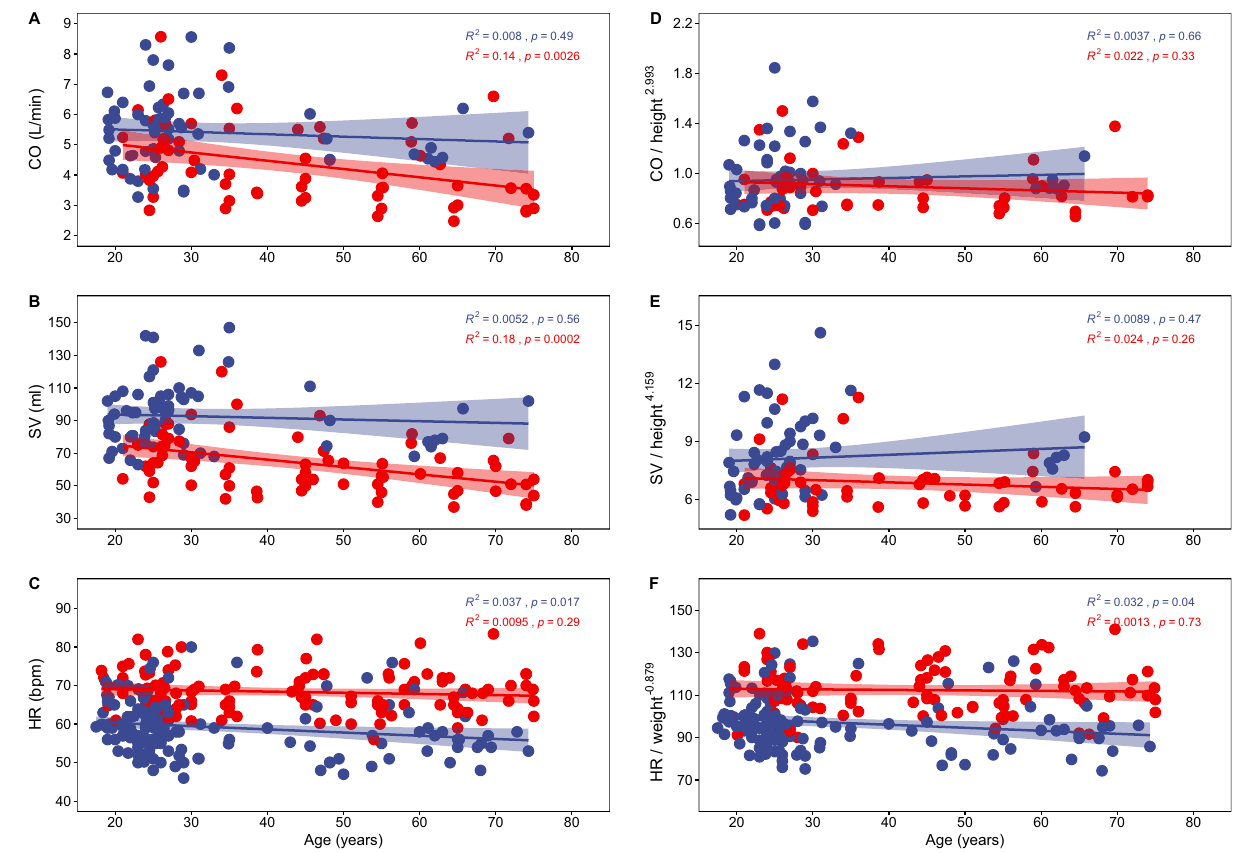
Figure 2. Cardiac output (CO, L/min), stroke volume (SV, mL), and heart rate (HR, beats per minute, bpm), across the adult lifespan for 101 to 277 human samples classified either as control (healthy persons who do not regularly practice sports, red dots), or physically active (either professional athletes or subjects who regularly practice sports, blue dots), obtained from a literature search (Supplementary Material 6). Values for the three variables are shown in ( A – C ), while values scaled to height (cardiac output, stroke volume), or weight (heart rate), raised to their correspondent exponents (see Supplementary Material 6), are shown in ( D , E ). Lines and shaded regions indicate simple linear regression analysis (ordinary least square, OLS), and 95% confidence intervals, with age as a predictor, and R 2 and p values for each regression are shown (see Supplementary Material